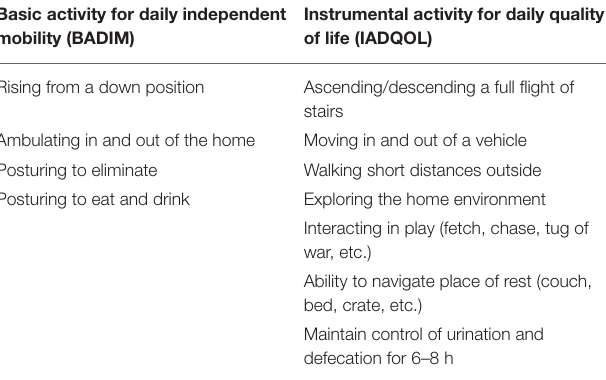
FIGURE 1 | Vigor in Aging People. Adapted from (10).